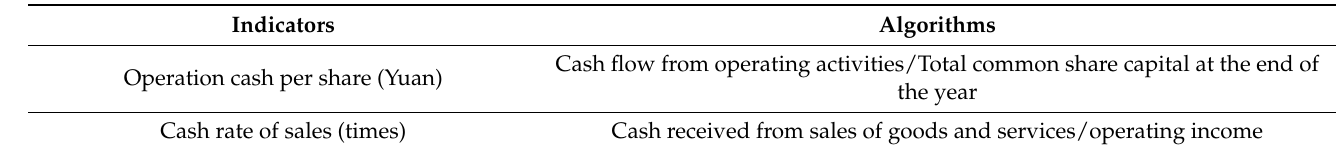
Table 10. Indicators and algorithms of Cash flow quality index.